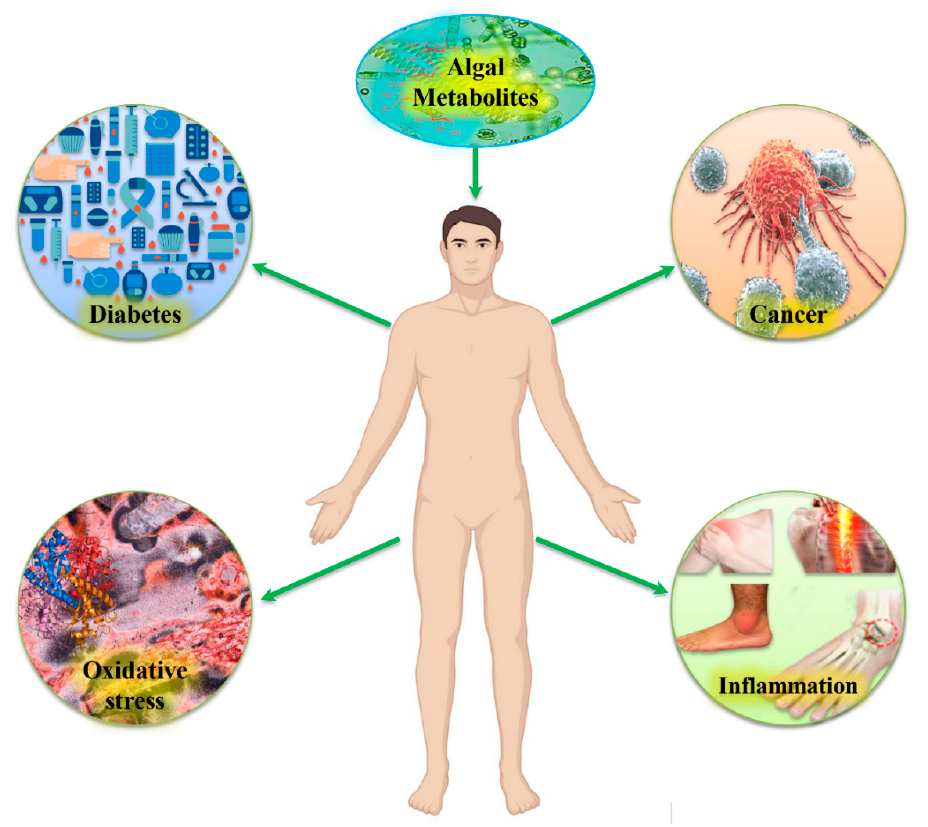
Figure 1. Potential beneficial effects of algal metabolites on human health. Secondary metabolites in marine algae could provide novel drug candidates for fighting various diseases, e.g., by reducing the α -amylase and α -glucosidase activity in diabetes; by reducing inflammation thanks to their antioxidant capacity; and inhibiting cellular proliferation in tumor cells.